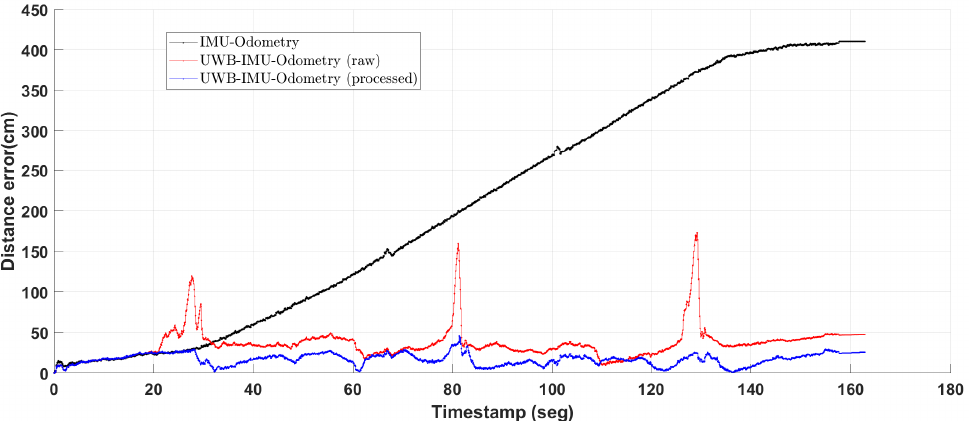
Figure 15. Comparison of the positioning distance error, (cid:101) p , of the different positioning